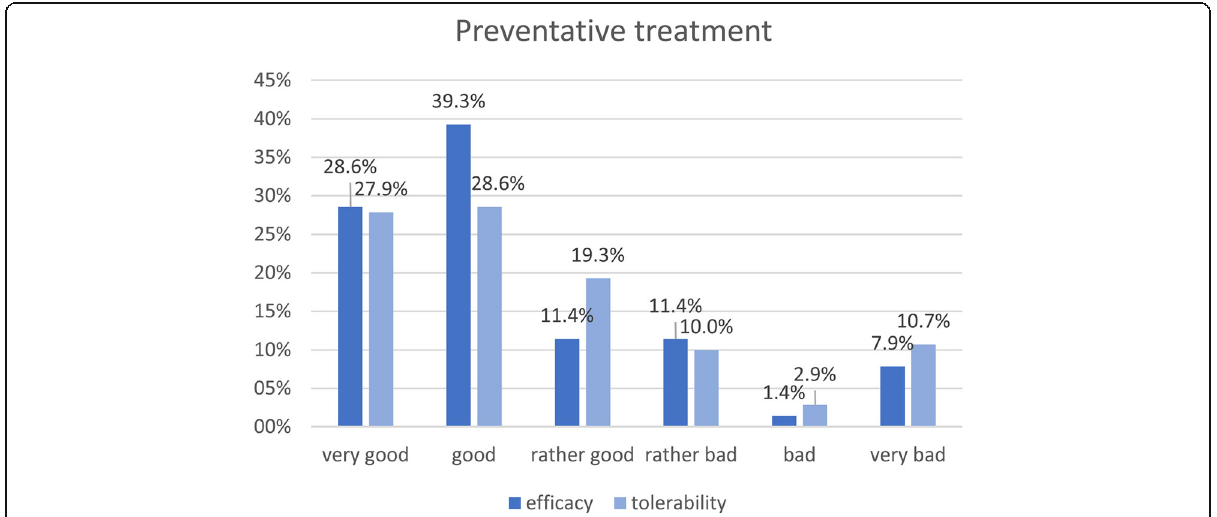
Fig. 4 Efficacy and tolerability of preventative treatments in general in patients that had more than 3 attacks per month but had previously not been prescribed a preventative migraine treatment. ( n =